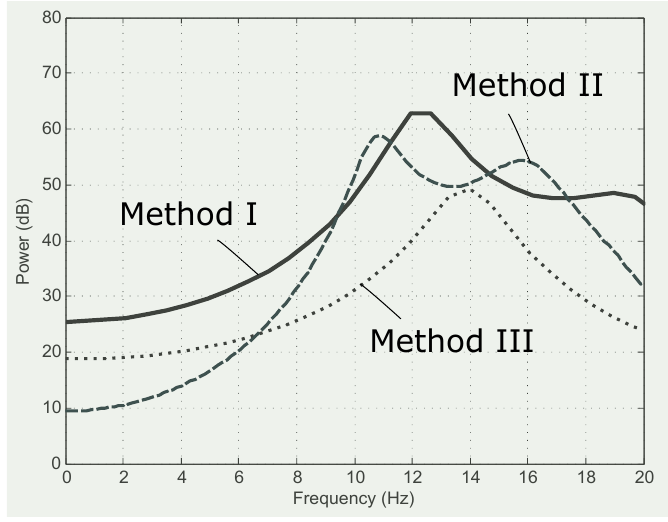
Figure 5. Comparison of power spectra for compression methods. The first 60 s of Record 100 from the MIT-BIH Arrhythmia